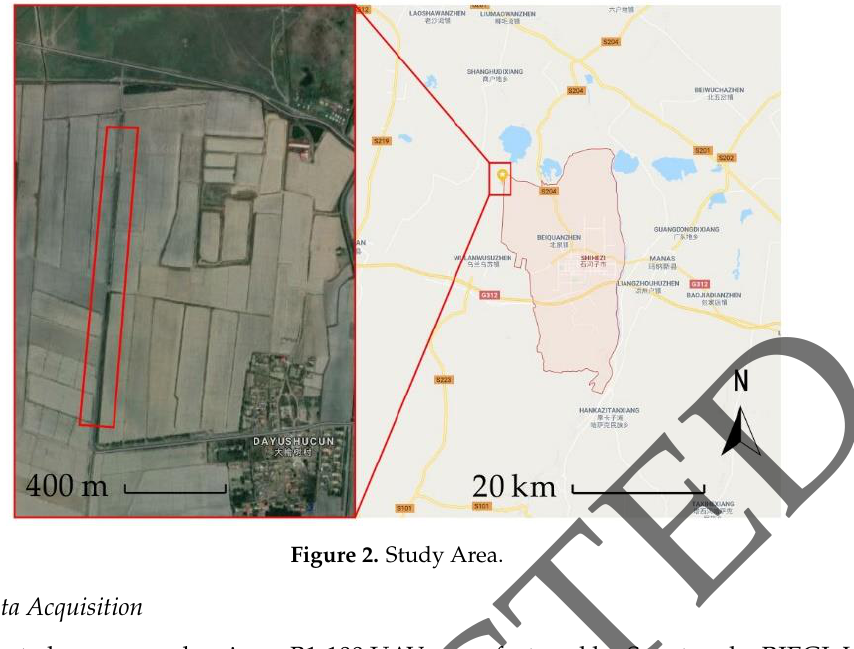
Figure 2. Study Area.